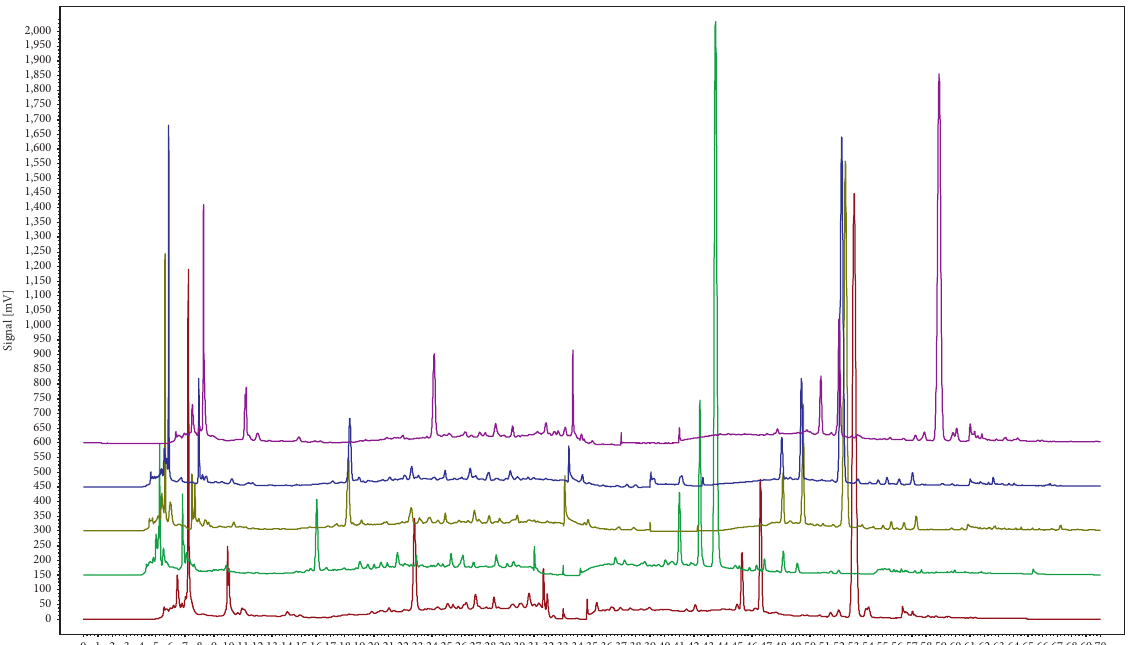
Figure 2: Separation results of different coupled columns by column switching technology. (a) Phenomenex Synergi Hydro-RP C18 (4 μ m, 250 × 4.6mm) and JADE-PAK C8 (3.5 μ m, 50 × 4.6mm), (b) ACE EXCEL C18 (5 μ m, 250 × 4.6mm) and JADE-PAK C8 (3.5 μ m, 50 × 4.6mm), (c) JADE-PAK C8 (5 μ m, 150 × 4.6mm) and JADE-PAK ODS-AQ (5 μ m, 150 × 4.6mm), (d) JADE-PAK C8 (5 μ m, 150 × 4.6mm) and Sharpsil-U C4 (5 μ m, 150 × 4.6mm), and (e) ACE EXCEL C18 (5 μ m, 250 × 4.6 mm) and JADE-PAK C8 (5 μ m, 150 ×